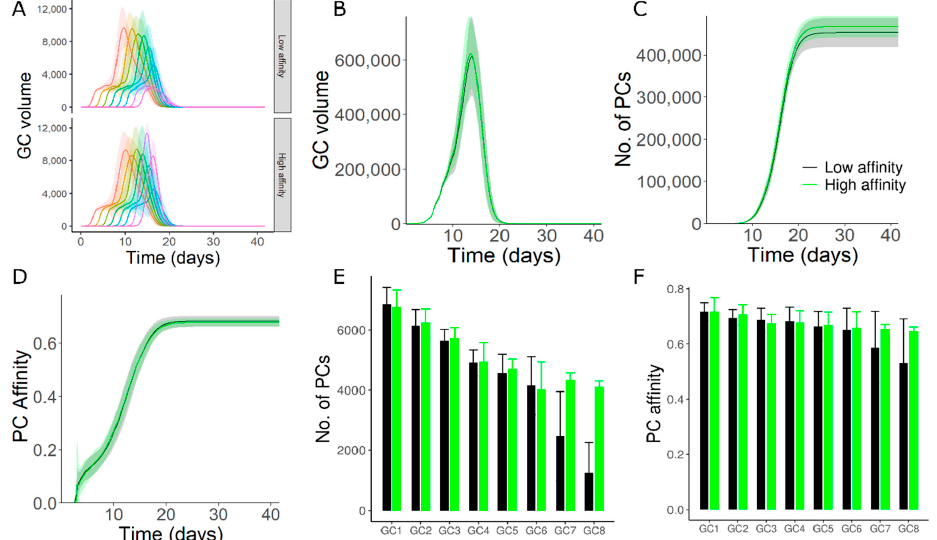
Figure 2. Simulation of late GCs with high affinity founder cells. ( A ) Volume kinetics of simulated GCs. GCs were initialized asynchronously and color code represents the timing of GC initiation. ( B ) Total volume of all GCs. ( C ) Plasma cell production from all GCs. ( D ) Affinity of plasma cells from all GCs. Readouts in B-D represent the sum of corresponding readouts of all simulated GCs weighted by the number of non-explicitly simulated GCs in each case. ( E ) Number of plasma cells produced from individual GCs. ( F ) Affinity of plasma cells from individual GCs. GCs 1–8 were sorted in the sequence of initiation. Inset in panel C applies for panels ( B – F ). In simulations labelled “Low affinity”, founder cells of GCs 1–8 were chosen randomly, and in “High affinity”, founder cells of GC7 and GC8 were chosen at a distance of 2 mutations from the optimal shape space position (3333). Strong GC–GC interaction strength (see methods) was considered in these simulations. 3.4. GC–GC Interactions Induce Diversity in Epitope Recognition among Individual GCs Given the potential role of GC–GC interactions in generating variability in the lifetime, kinetics and affinity maturation of individual GCs, we investigated whether GC– GC interactions also lead to differences in affinity maturation to individual epitopes in the presence of multiple epitopes. We tested the affinity of plasma cells at the end of the GC response from individual GCs in the presence of two epitopes (shape space positions 3333 and 5555) in equal proportion with founder cell positions randomly chosen anywhere in the shape space. With no interaction between GCs, plasma cells from individual GCs had similar affinities to both the epitopes, suggesting that individual GCs support affinity maturation to diverse epitopes. GC–GC interactions increased differences in plasma cell affinity between the two epitopes in individual GCs (Figure 3). Late formed GCs tend to have a higher affinity towards one of the epitopes, while the affinity towards the other